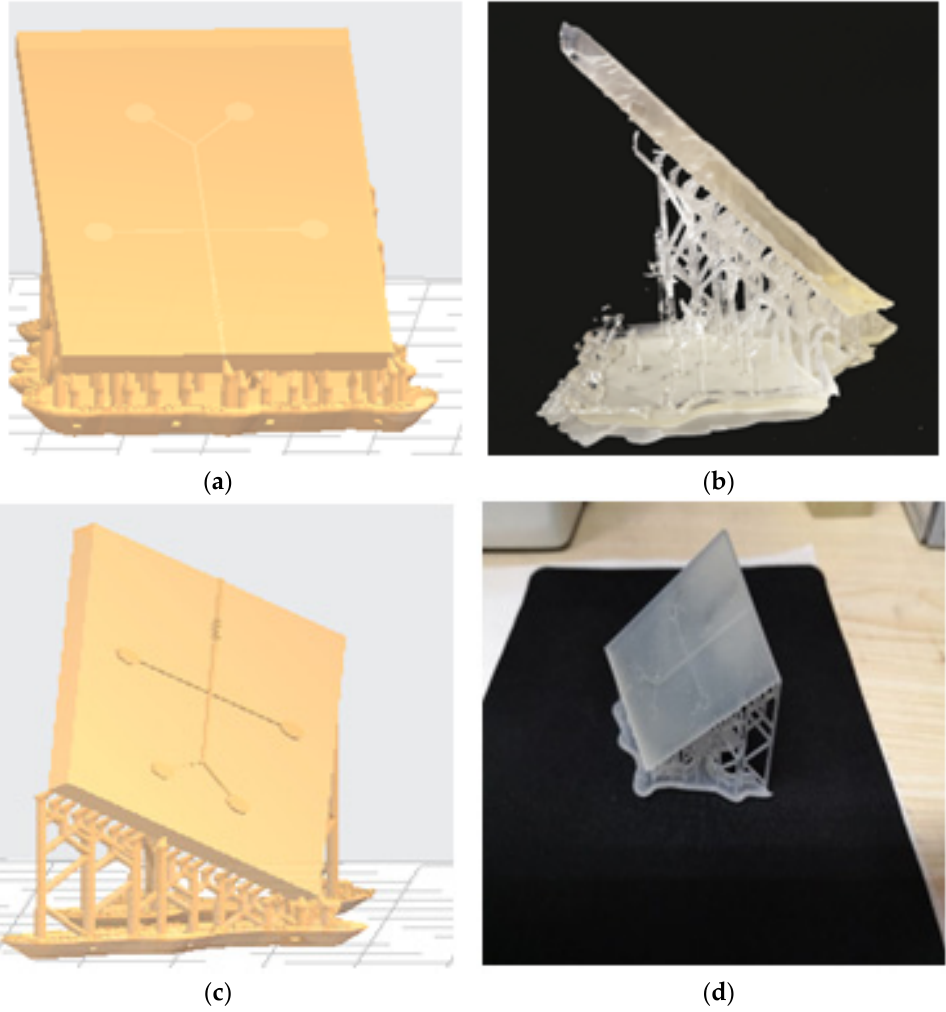
Figure 3. ( a ) Non-single-angle printing three-dimensional model; ( b ) non-single-angle printing effect diagram; ( c ) single-angle printing three-dimensional model; ( d ) single-angle printing effect. (3) Post-printing processing